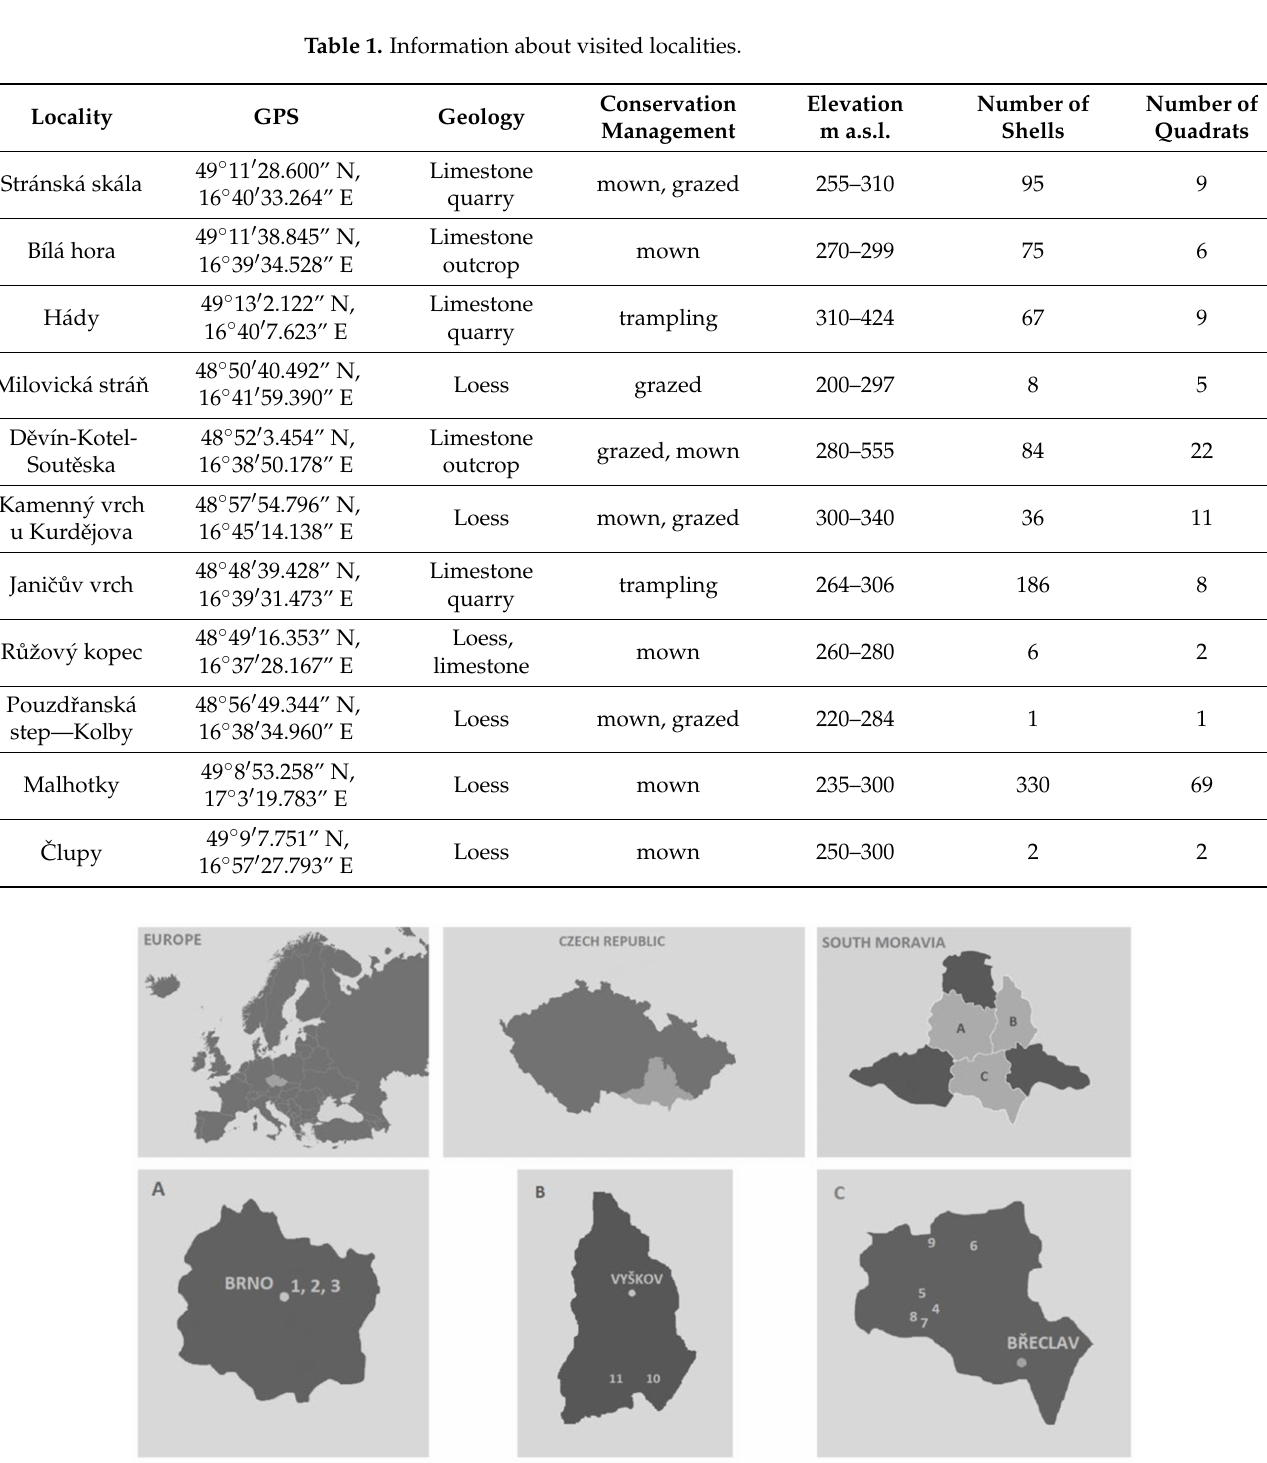
Figure 1. Locations of collecting areas. Area of Brno (Picture A): (1) Str á nsk á sk á la, (2) B í l á hora, (3) H á dy. Area of Bˇreclav (Picture C): (4) Milovick á str á ˇn, (5) Dˇev í n-Kotel-Soutˇeska, (6) Kamenn ý vrch. u Kurdˇejova, (7) Janiˇc˚uv vrch, (8) R˚užov ý kopec, (9) Pouzdˇransk á step. Area of Vyškov (Picture B): (10) Malhotky, (11)